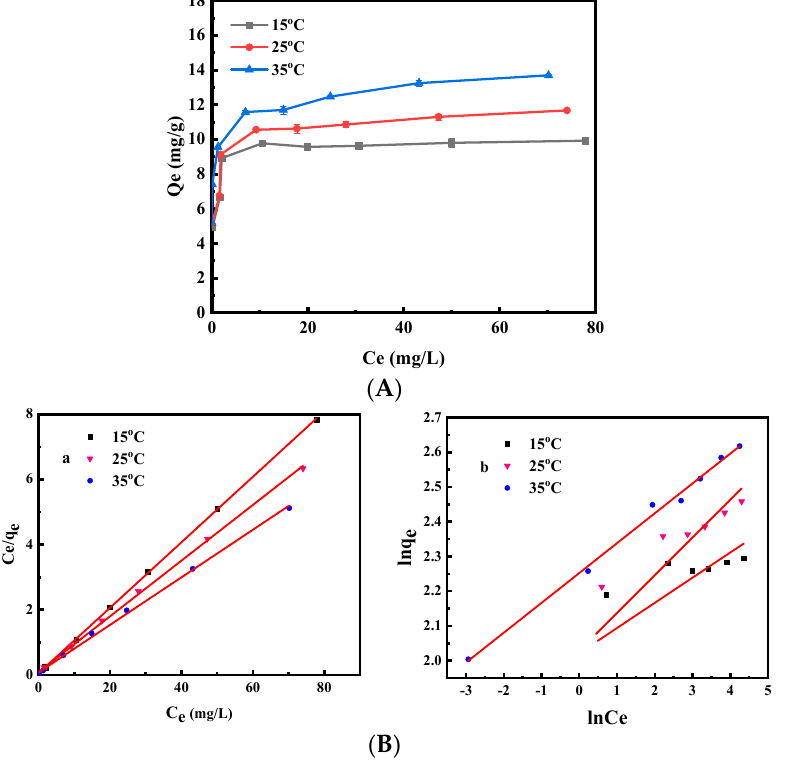
Figure 7. ( A ) Isotherms of Cr(VI) adsorption removal by MHDB ( C 0 = 10–100 mg/L, pH = 2, time = 48 h, and temperature = 15, 25 and 35 °C); ( B ) adsorption isotherms of Cr(VI) by fitting the Langmuir isotherm model ( a ) and Freundlich isotherm model ( b ).